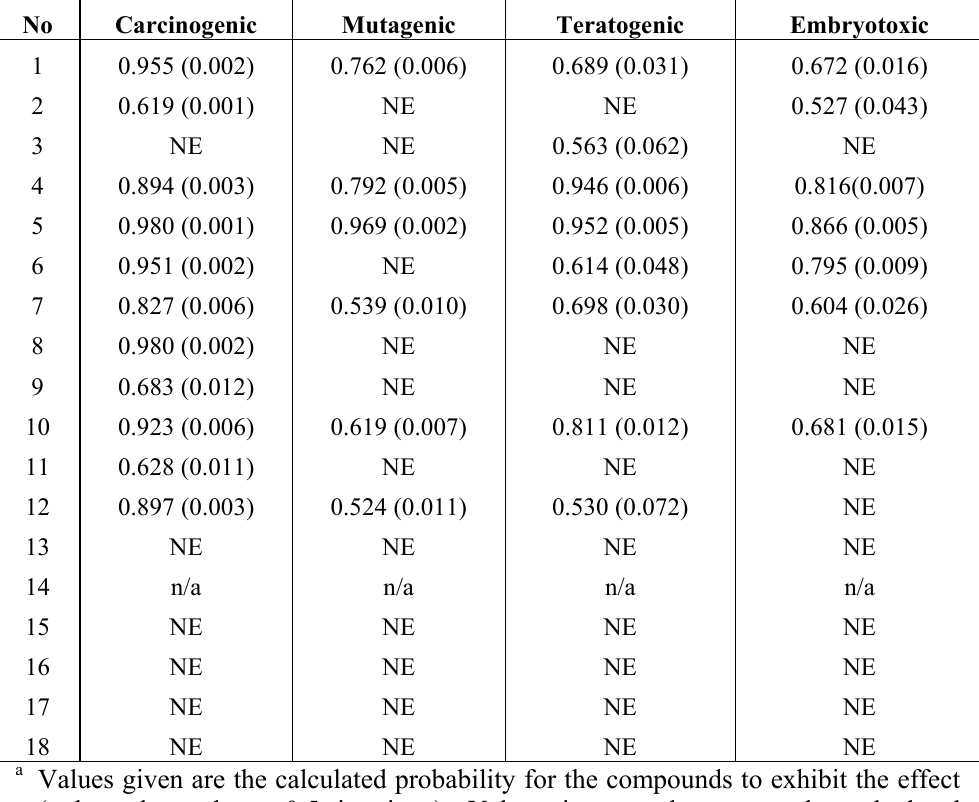
Table 6 . PASS predictions of selected biological activities a